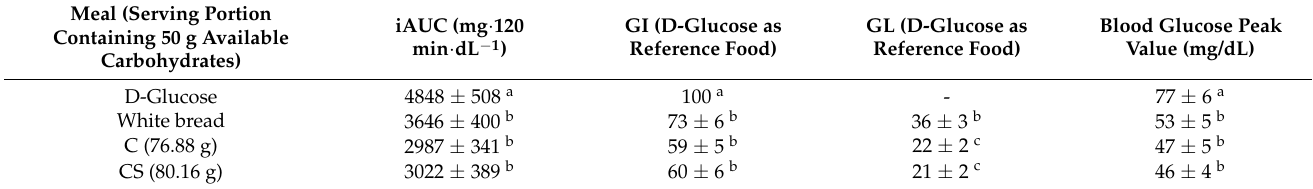
Table 5. Incremental area under the curve (iAUC) for blood glucose, glycemic index (GI), glycemic load (GL), and peak for blood glucose values of cookie without spirulina (C), cookie with spirulina (CS), and white bread, relative to the reference food